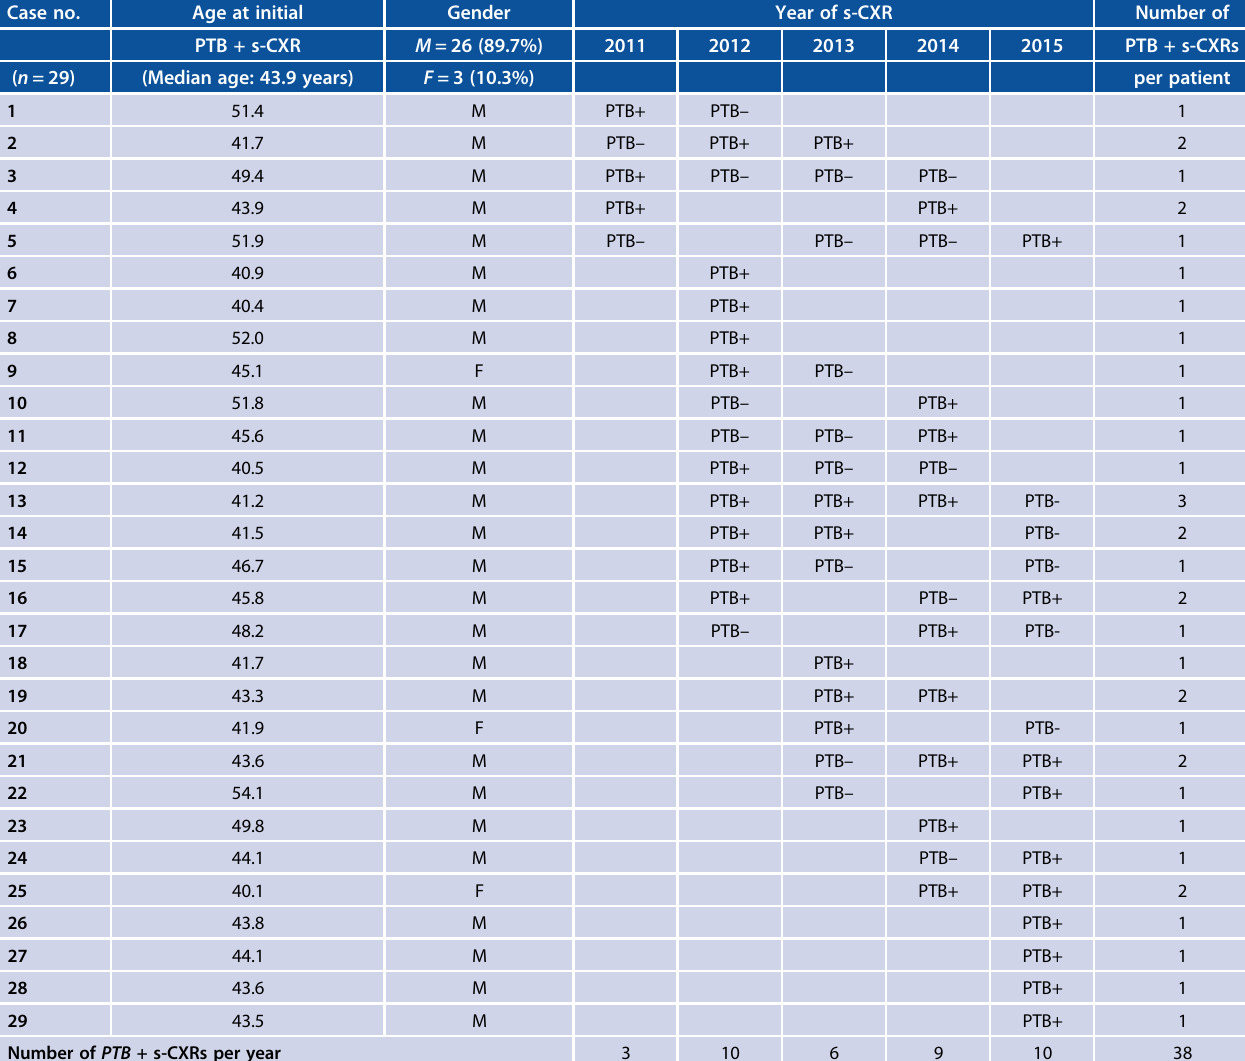
Table 2: Summary of all s-CXRs done on the 29 patients diagnosed with pulmonary tuberculosis during the study period Case